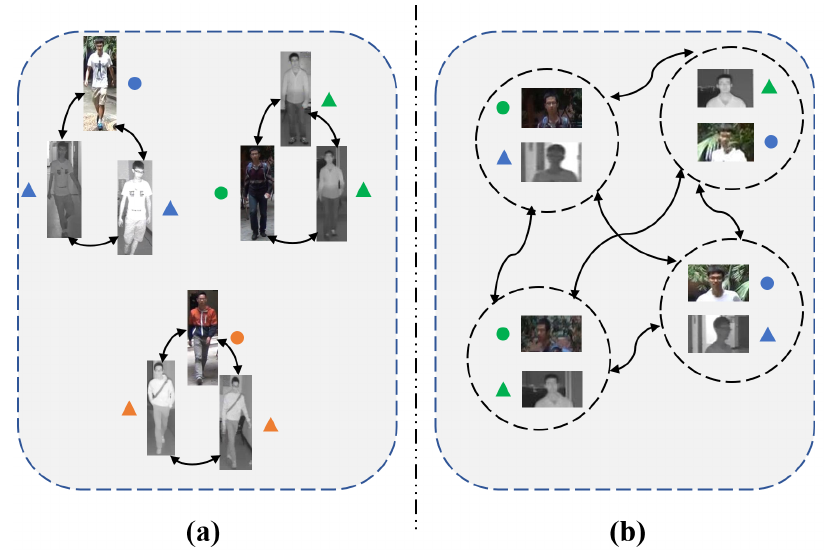
Figure 1. ( a ) Most methods for cross-modality person ReID treat each pedestrian image as a node of a graph. ( b ) The proposed method treats paired local features from different modalities as a node of a graph. We distinguish the pedestrian identities using different colors, with the same color indicating the same pedestrian. Circles and triangles are used to represent the IR and RGB modalities,